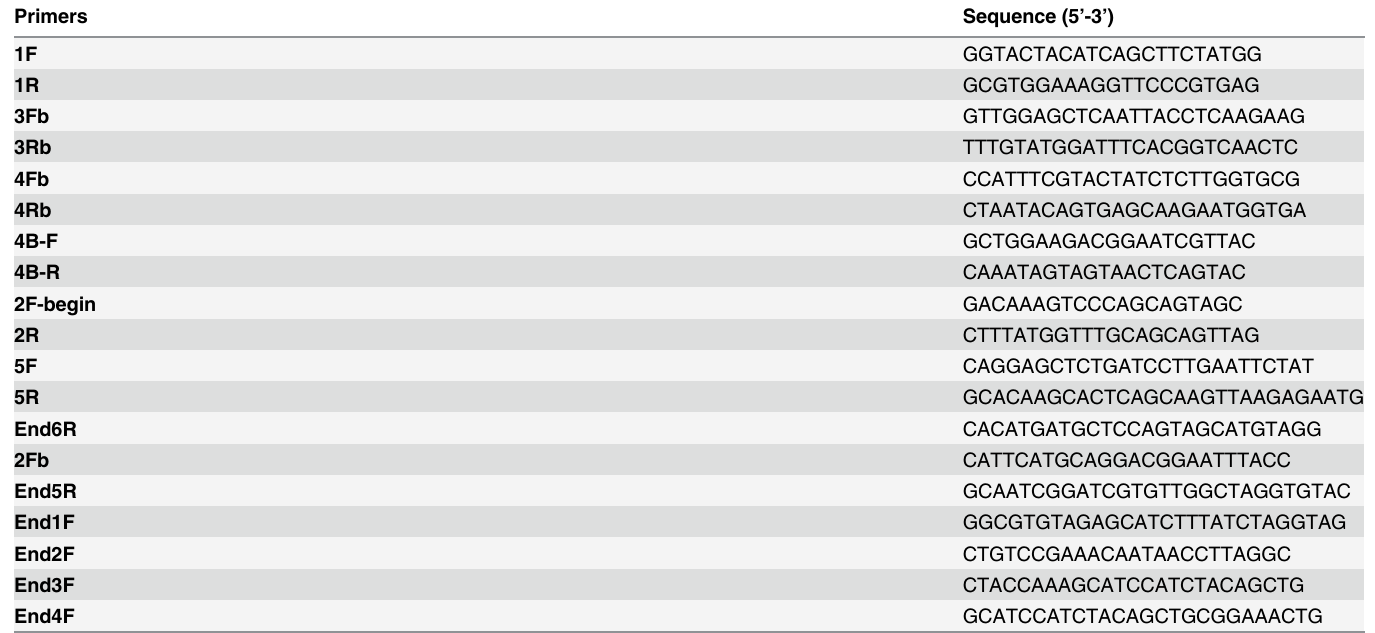
Table 1. Primer sequences used for